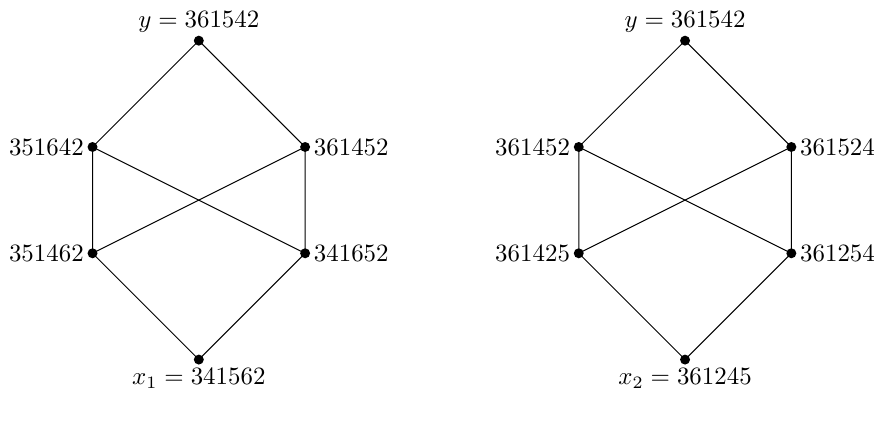
Fig. 6: The intervals [ x 1 , y ] and [ x 2 , y ] described in Example 4.11, illustrating the proof of Theorem